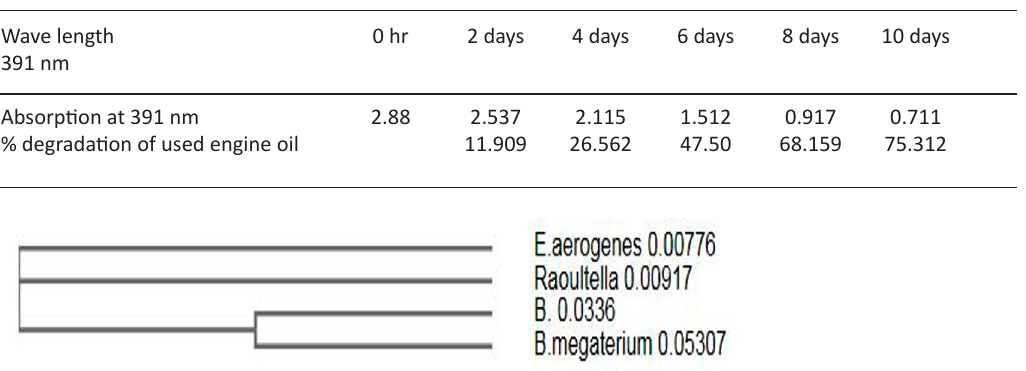
Fig. 5. Phylogenetic tree expressing the relationships among UEO degrading isolates based on the 16S rDNA sequences